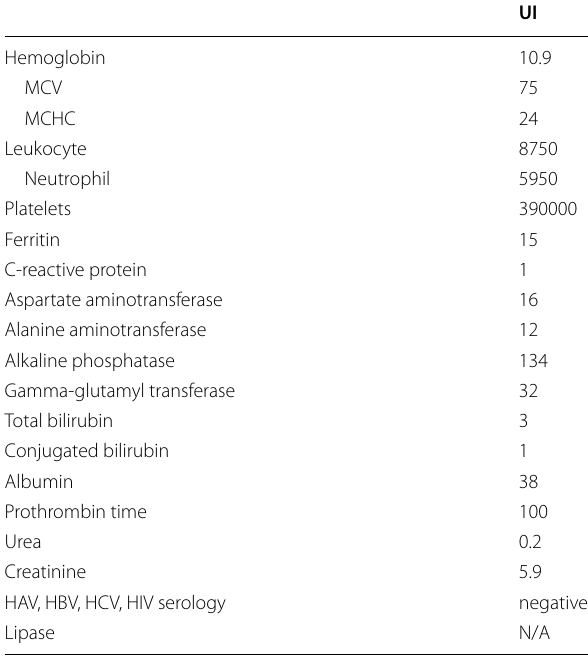
Table 1 Blood test results of our patient